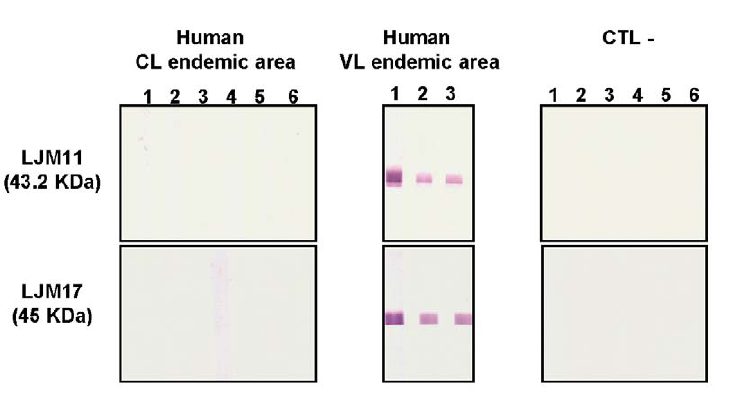
Figure 6. Detection of the recombinant salivary proteins LJM17 and LJM11 by human sera from endemic areas. Western Blot with LJM17 or LJM11 recombinant proteins were screened with sera from humans in Canoa where Lutzomyia intermedia predominates ( Human – CL endemic area) or with sera from Sa˜o Luis area where Lu. longipalpis predominates (Human – VL endemic area). Sera from individuals from a non- endemic area were used as negative controls